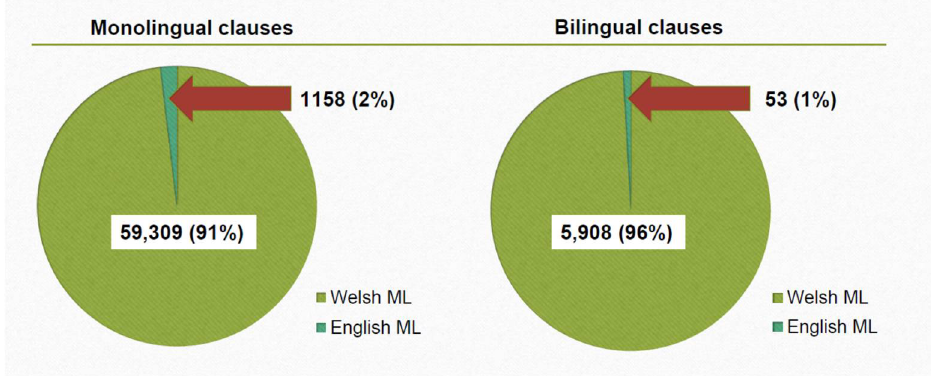
Figure 5. Quantitative distribution of matrix language in Siarad corpus.